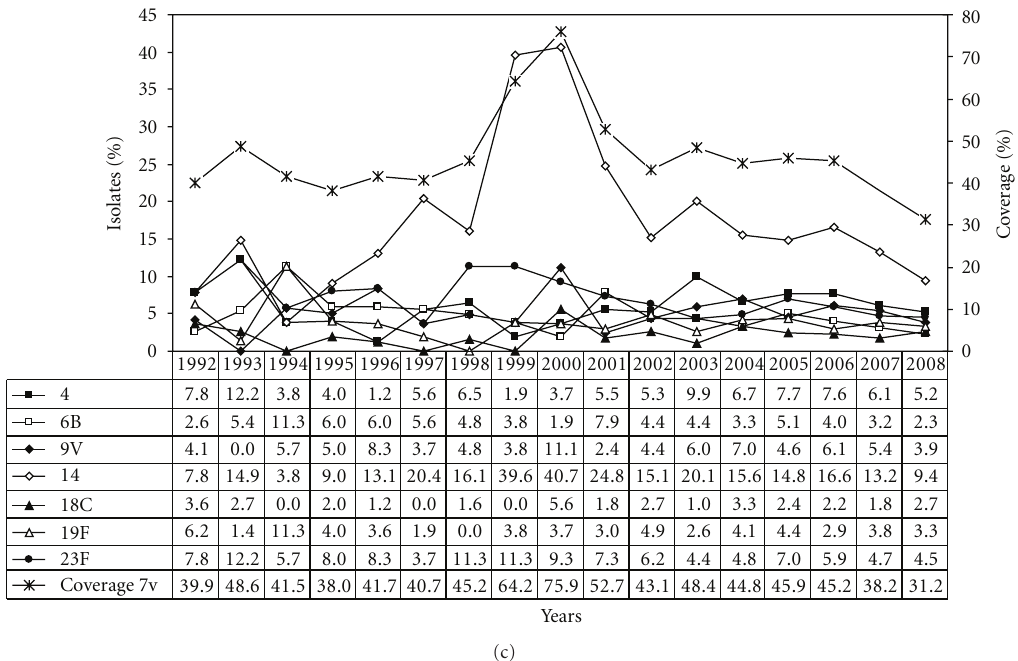
Figure 2: (a) Distribution of the 7-valent pneumococcal conjugate vaccine serotypes and the 7-valent vaccine coverage in percent (1992– 2008, n = 9,394). (b) Distribution of the 7-valent pneumococcal conjugate vaccine serotypes and the 7-valent vaccine coverage among children in percent (1992–2008, n = 2,948). (c) Distribution of the 7-valent pneumococcal conjugate vaccine serotypes and the 7-valent vaccine coverage among adults in percent (1992–2008, n =